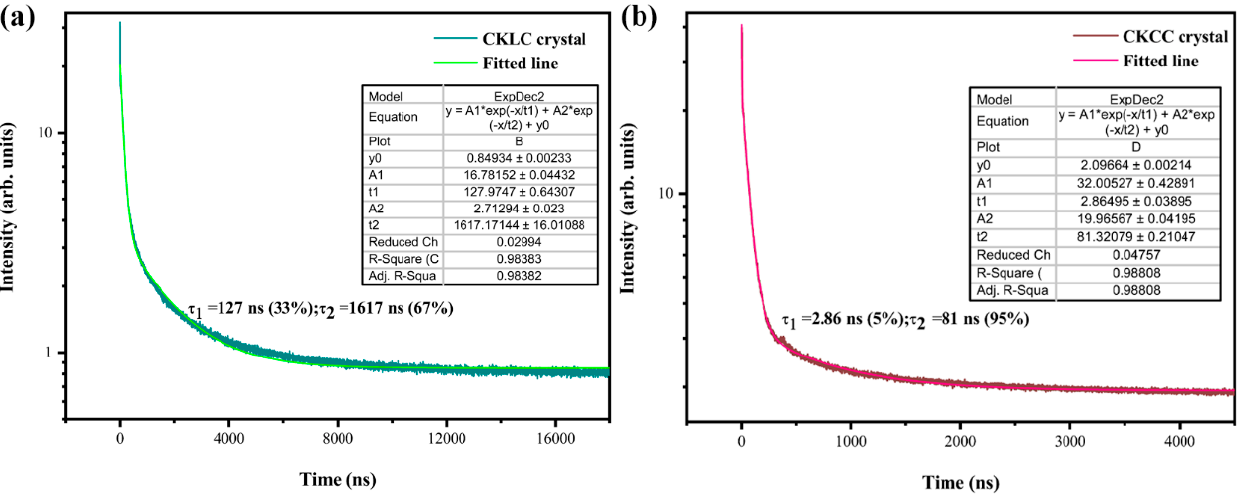
Figure 8. The scintillation decay time curve of ( a ) CKLC and ( b ) CKCC crystals measured under 137 Cs γ -rays excitation at room temperature.